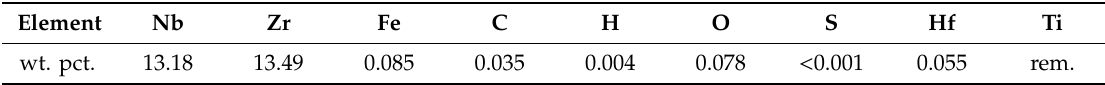
Table 1. Chemical composition of the Ti13Nb13Zr alloy.